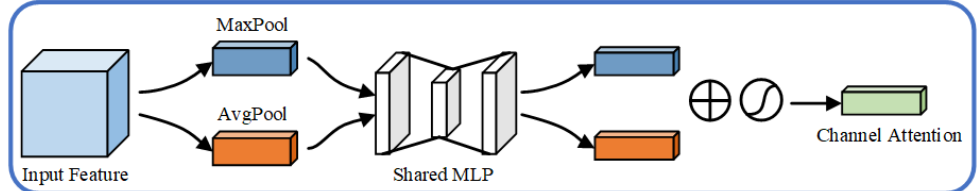
Figure 5. The structure of the channel attention module, reprinted with permission from Ref. [21]. 2018, Springer Nature.